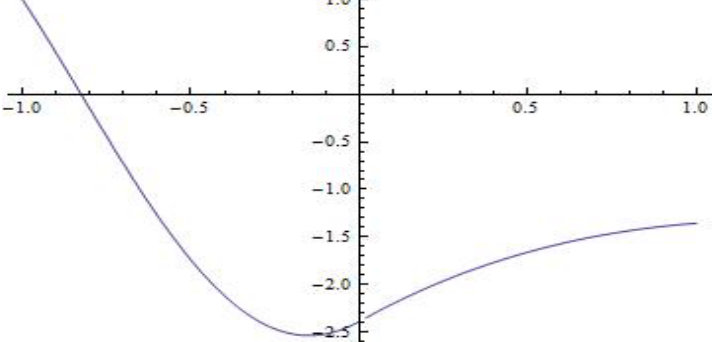
Figure 10. Graph of the eigenfuction corresponding to the eigenvalue λ 3 = 5.41871. (This graph was sketched by using “Mathematica